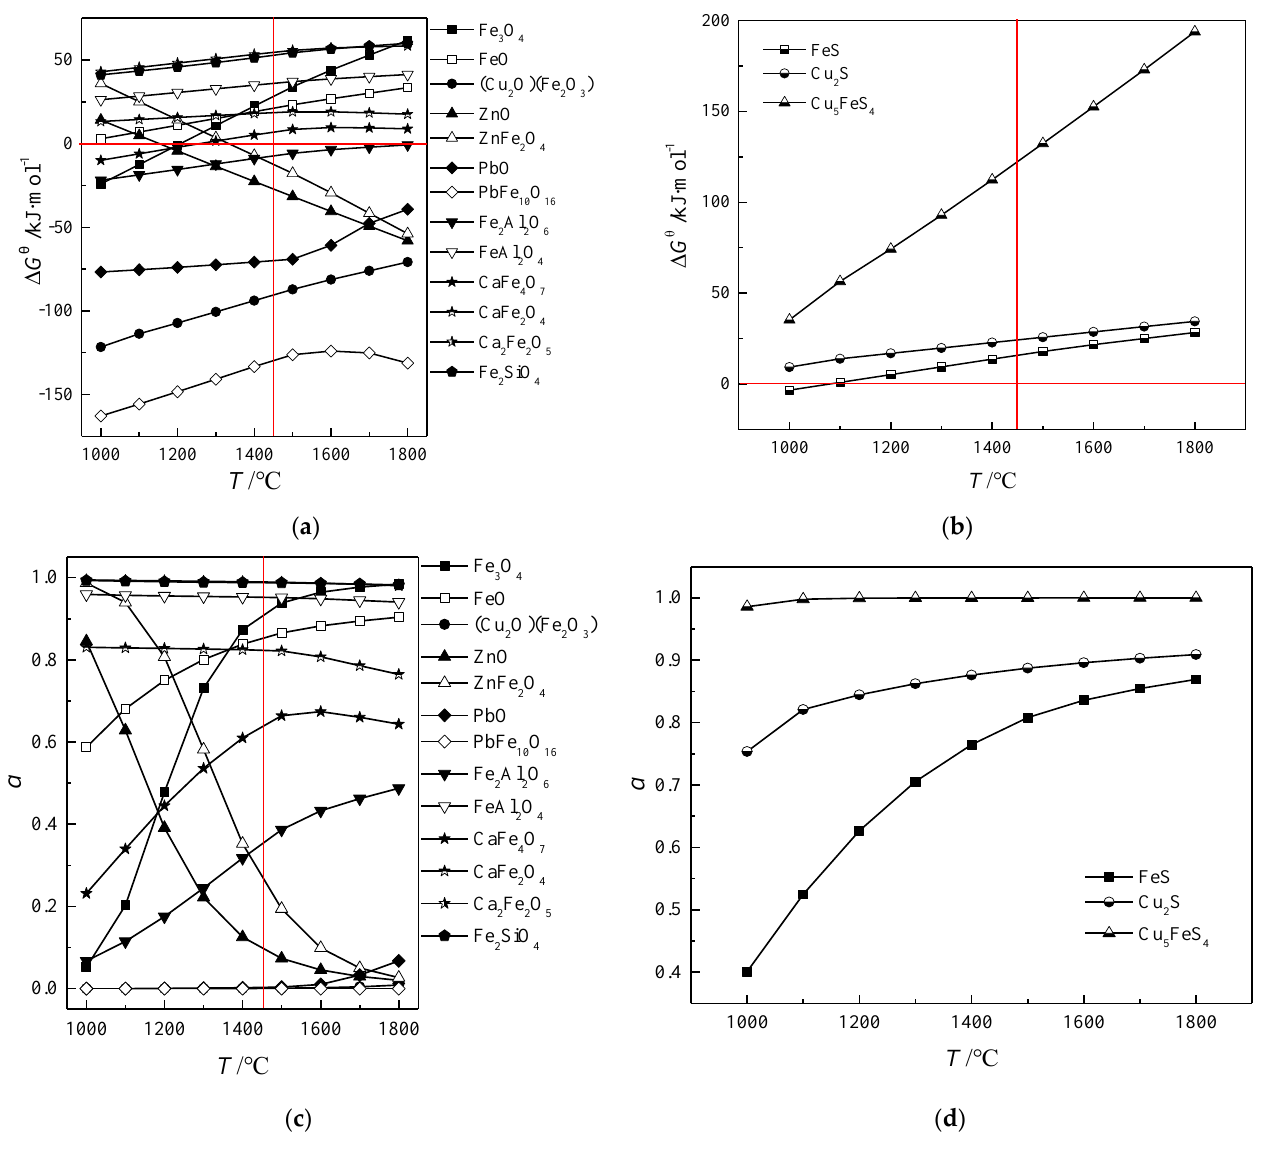
Figure 5. ∆ G θ of the reactions and the equilibrium partial pressure under non － standard state ( a , c ): oxides, ( b , d ): sulfides.